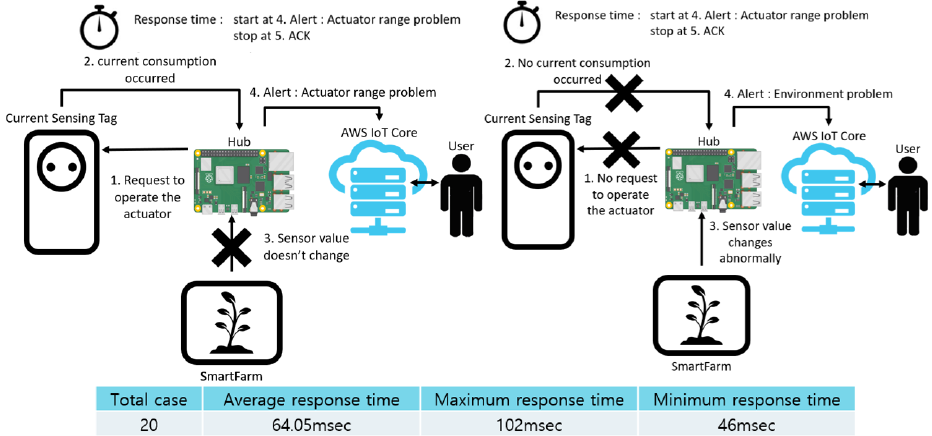
Figure 25. Response time in exceptional case: actuator range problem and environment problem.